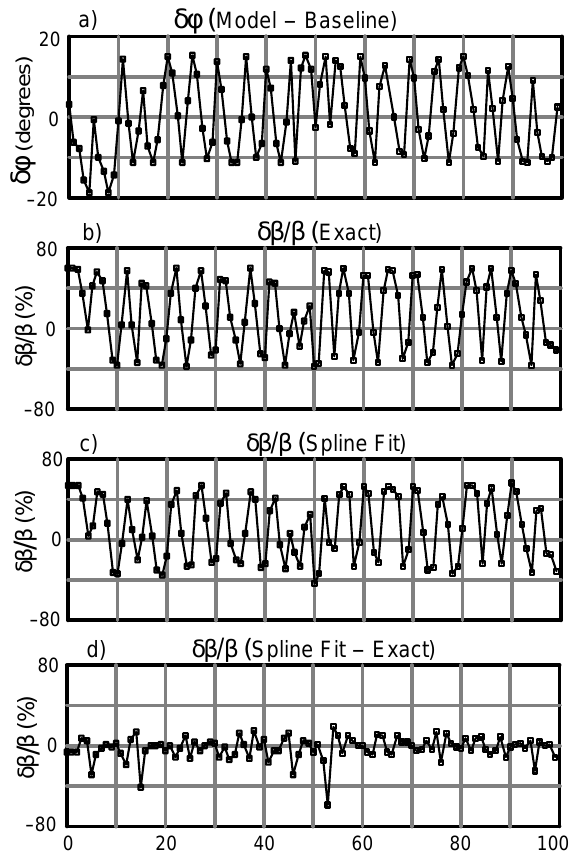
FIG. 4. Example db (cid:1) b calculation from the phase data. The horizontal scale for the phase data is the beam detector index while for the b data the horizontal scale is the quadrupole index. (a) Phase difference between a model lattice and a base line lattice. (b) Exact db (cid:1) b as calculated from the model and base line lattices. (c) db (cid:1) b as calculated from a spline fit of (a). (d) Difference between (b) and